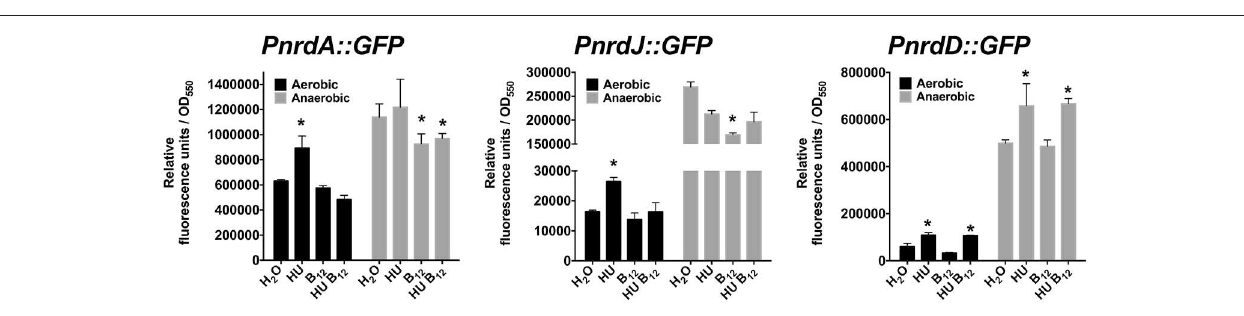
FIGURE 2 | Expression analysis of the different P. aeruginosa PAO1 RNR classes under HU and vitamin B 12 treatment under aerobic and anaerobic conditions. Cultures were treated in the presence of HU (30mM) and vitamin B 12 (1 µ g/ml) for 20min prior to measure the relative fluorescence units of PnrdA (pETS134) , PnrdJ (pETS180 ) and PnrdD (pETS136). The results are the mean of three independent experiments ± standard deviation. Asterisks over bars (*) indicate statistical differences compared to those without treatment (H 2 O) ( p < 0.05 in pairwise t- test calculated with GraphPad 6.0).